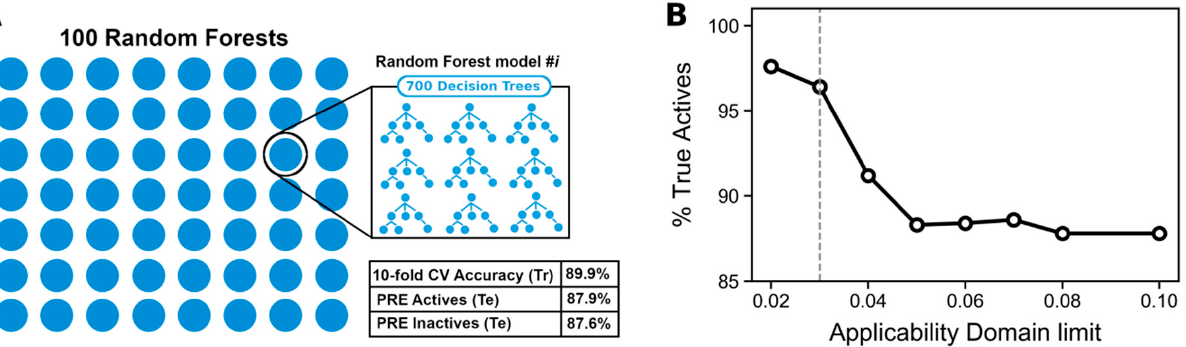
Figure 12. ( A ) Conceptual representation of the QSAR model, which consists of an ensemble of 100 random forests where each random forest model is composed of 700 decision trees. The ta- ble in the lower corner summarizes training and test performance. Tr: Training set, Te: Test set. ( B ) Applicability domain curve of the final QSAR model, where % True Actives refers to the test